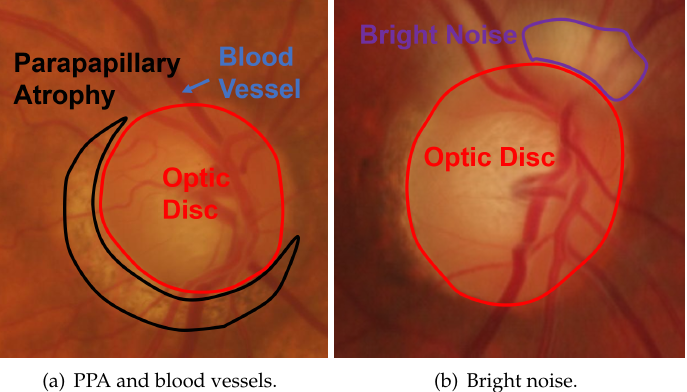
Figure 3. Problems in OD